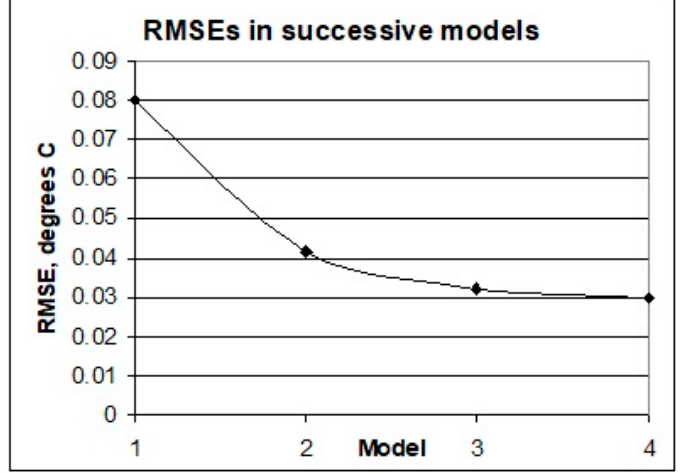
Figure 7. Root mean square errors (RMSEs) in successive models for decadally smoothed HadCRUT4 anomalies. Table 5. Statistical results for succeeding models of simulating HadCRUT4 decadally smoothed GMST